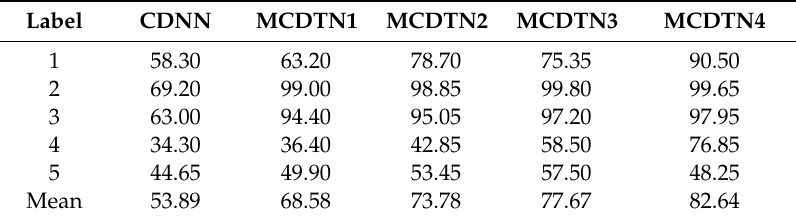
Table 8. The accuracy of DNN and DTNs when the ratio of incomplete data to structurally-complete data is 30:1.